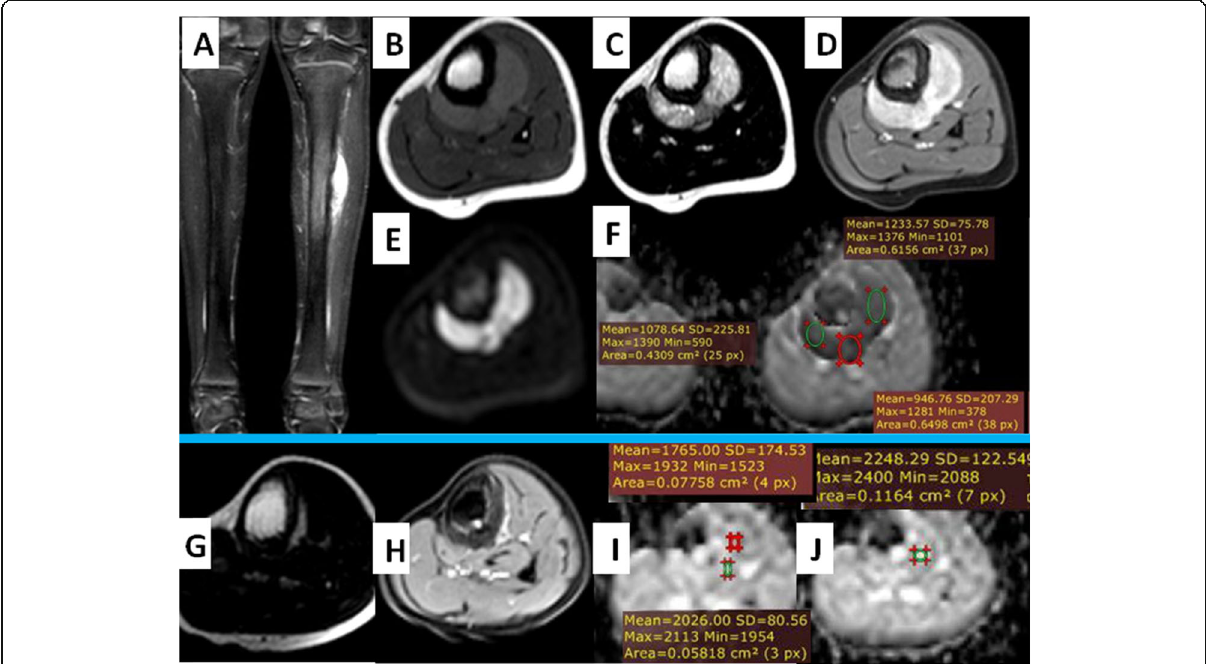
Fig. 4 A 9-year-old female, diagnosed as parosteal osteosarcoma of left tibia. MR images a – f before and g – j after chemotherapy. a – d Coronal STIR, Axial T1, T2-WI and contrast-enhanced T1-WI showing cortically based diaphyseal mass lesion circumferentially involving the anterolateral and posterior surfaces of the left tibial mid shaft with thickening of the cortex. It elicits heterogeneous high signal in STIR, low signal in T1, high signal in T2, with heterogeneous contrast uptake. e , f DWI and ADC map showed diffusion restriction with mean ADC values about (mean, 1.08 × 10 − 3 mm 2 /s). g , h Follow-up axial T2 and axial post contrast showing marked regression in the size and enhancement of the mass. i , j Follow-up ADC mapping and ROI inserted over the most restricted areas revealed increase in the values (mean values of 2 × 10 − 3 mm 2 /s) denoting good